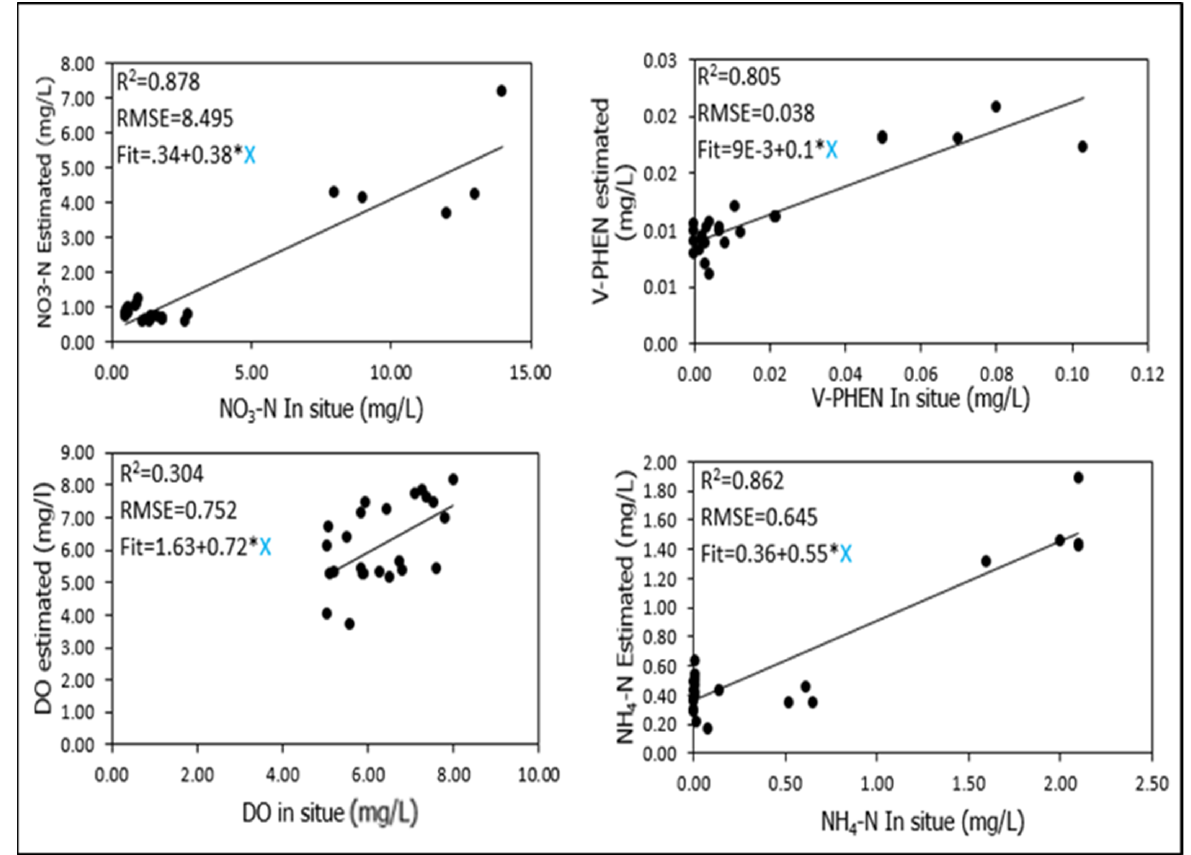
Figure 3. Relational plot of the in situ water quality parameters and estimations from Landsat (TM, ETM, and OLI) in Erlong Lake .